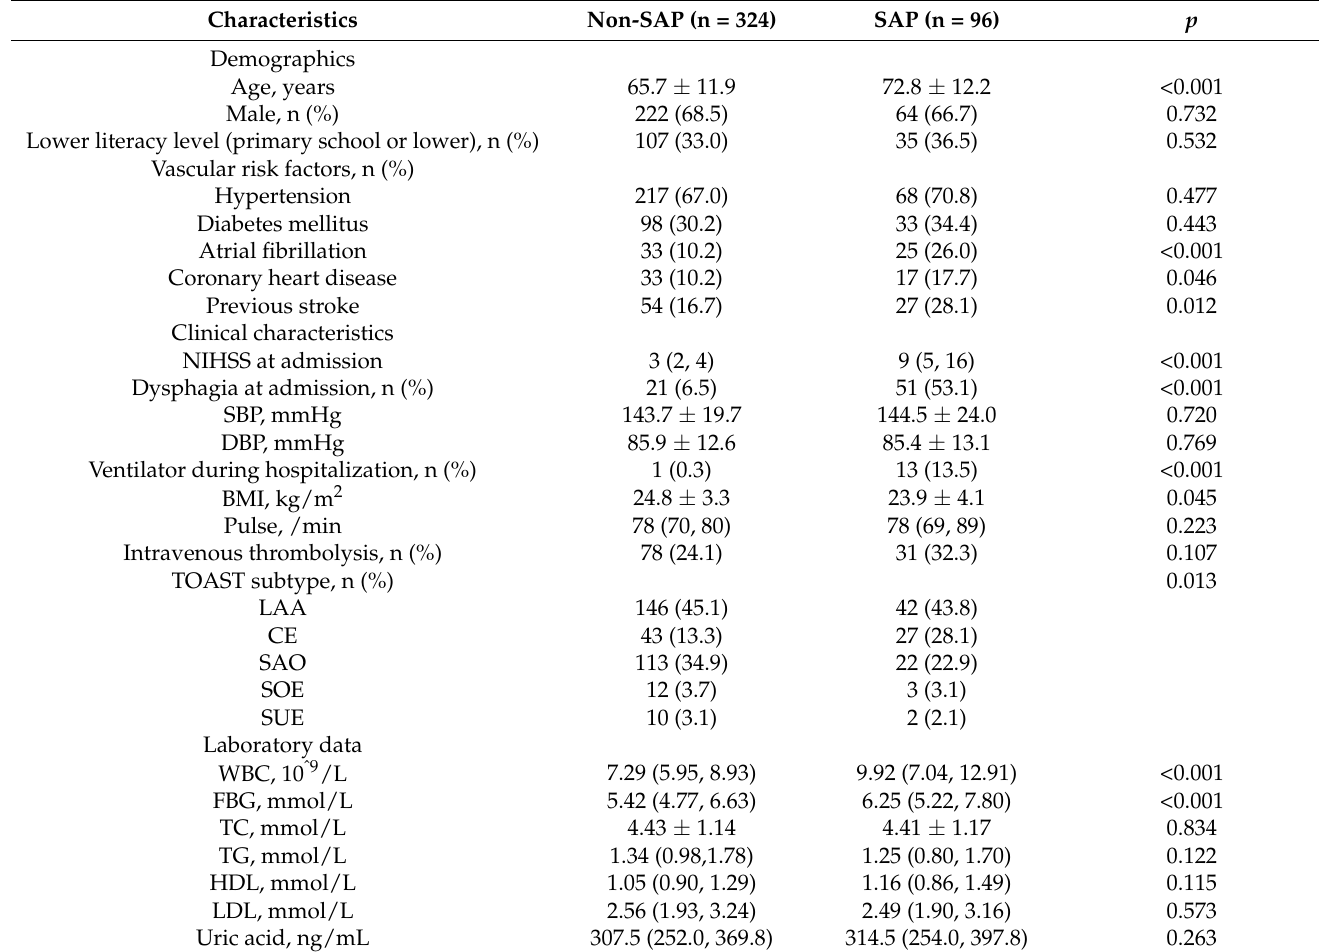
Table 1. Characteristics of all patients referred with